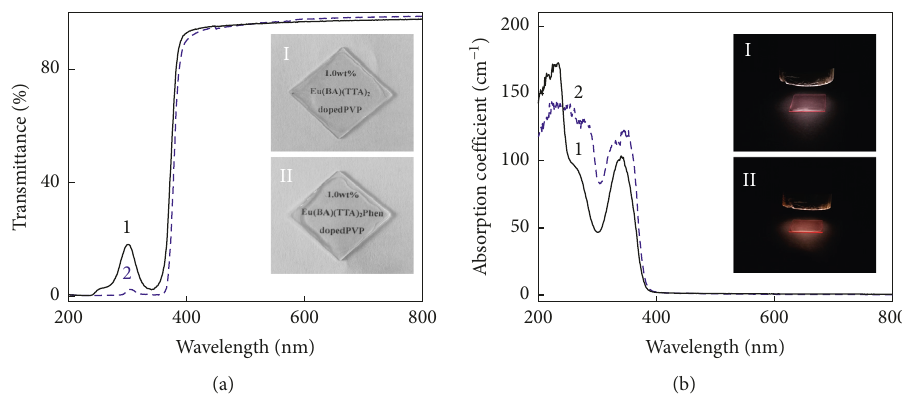
Figure 12: UV-Vis transmission spectra (a) and absorption spectra (b) of Eu(BA)(TTA) (curve 2). The thickness of Eu(BA)(TTA) 2 /PVP and Eu(BA)(TTA) 2 Phen/PVP is 0.160mm and 0.198mm, respectively. The insets are the samples without (I) and with (II) Phen under direct sunlight, respectively.